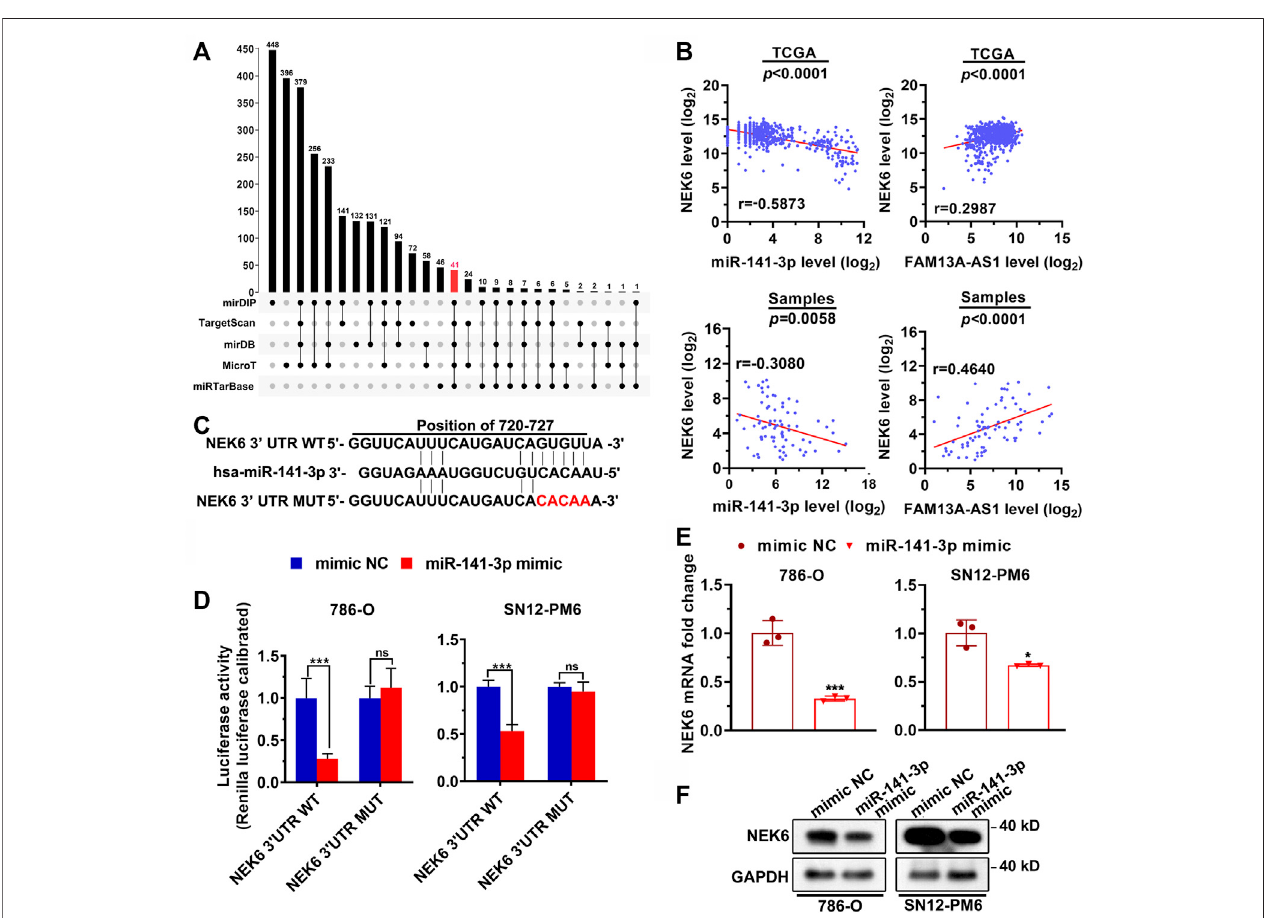
FIGURE 5 | FAM13A-AS1 sponges miR-141-3p to upregulate its target NEK6. (A) Upset plot showing the intersections between fi ve sets of computationally identi fi ed miR-141-3p targeting genes. (B) Correlation between NEK6 and miR-141-3p or FAM13A-AS1 expression in RCC from TCGA and our own cohorts. (C) SchematicshowingthepredictedmiR-141-3pbindingsitesin3 ′ UTRofNEK6wild-typeandmutantescapingthebindingofmiR-141-3p.Therednucleotidesrepresent mutations on target sites. (D) Bar plot showing the luciferase activities in 786-O and SN2-PM6 cells co-transfected with wild-type (WT) or mutant (MUT) NEK6 plasmidtogetherwithmiR-141-3p mimicornegativecontrol(NC). (E,F) Barplots (E) andblottingimage (F) showingthemRNAand proteinlevelsofNEK6expression in 786-OandSN2-PM6cellstransfectedwithmiR-141-3pmimic,ornegativecontrols(NC)fromRT-qPCRandwesternblotanalysis.Datarepresentthemean±SD.**: p < 0.01; ***: p < 0.001; ****: p <